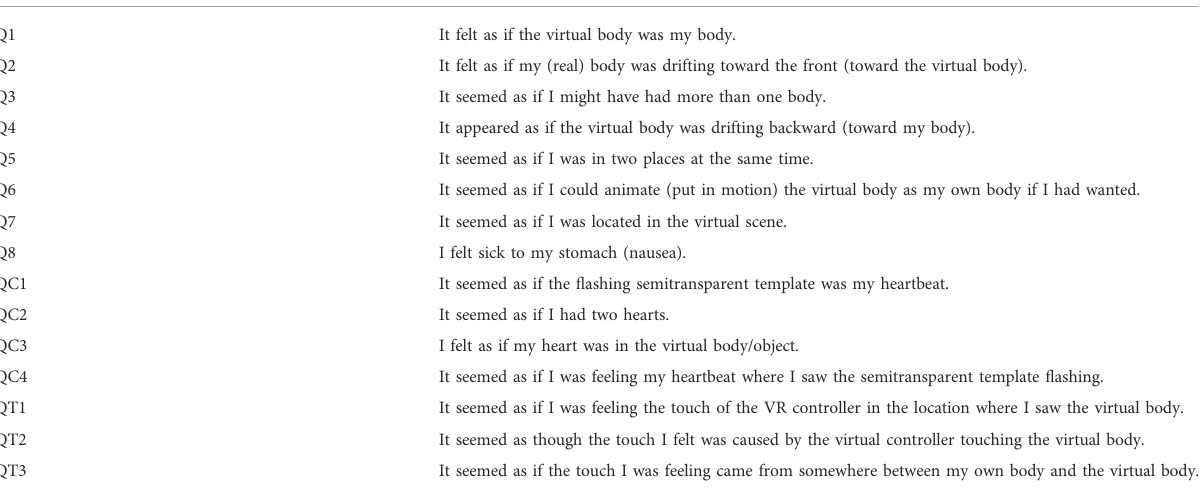
TABLE1Illusionquestionnaire.Questionsarepresentedintheorderindicatedbynumber.Itemsrelativetothecardio-visualillusion(QC1,QC2,QC3, and QC4) and visuo-tactile illusion (QT1, QT2, and QT3) are only displayed during the corresponding